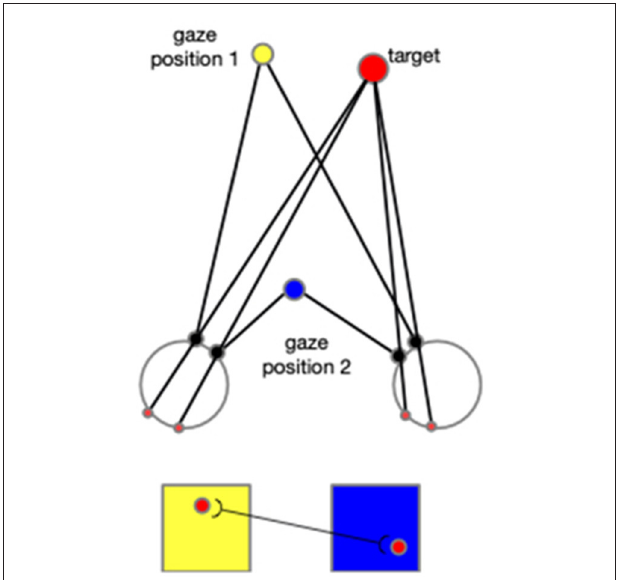
FIGURE 15 | When the eyeballs rotate to fix on the gaze position 2 from the previous fixation (gaze position 1), a spot’s projection on the two retinas moves accordingly. Two cells activated sequentially from the corresponding two CPM are then associated. In this figure, the yellow square represents the CPM of gaze position 1, and the blue square represents the CPM of the gaze position 2. The red disks represent the target and its projections on retinas and